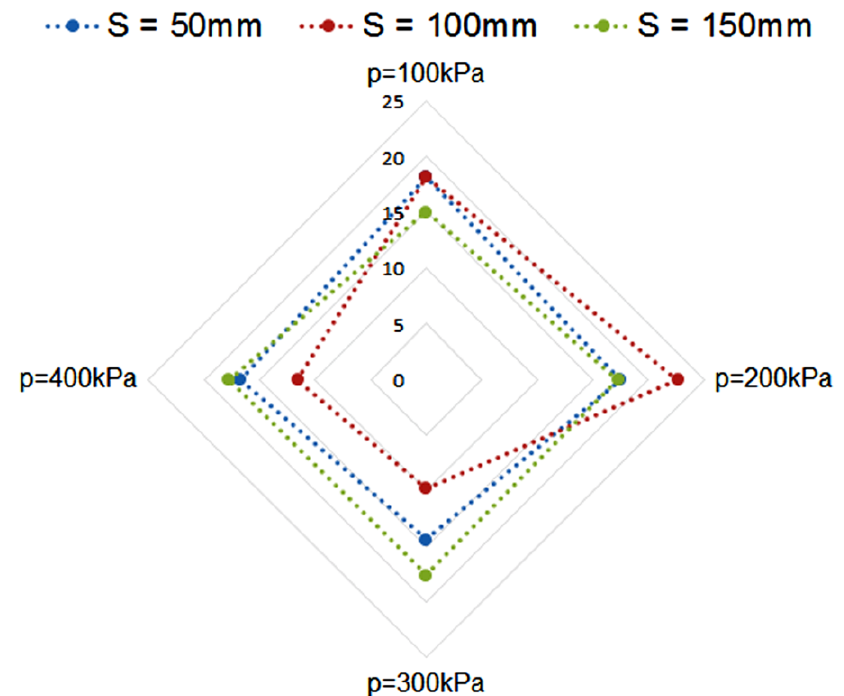
Figure 6. The amount of the chemical agent (g) on the seed potato surface for the electronically controlled valve, depending on the falling path distance (mm) (air pressure reduced by 50 kPa).